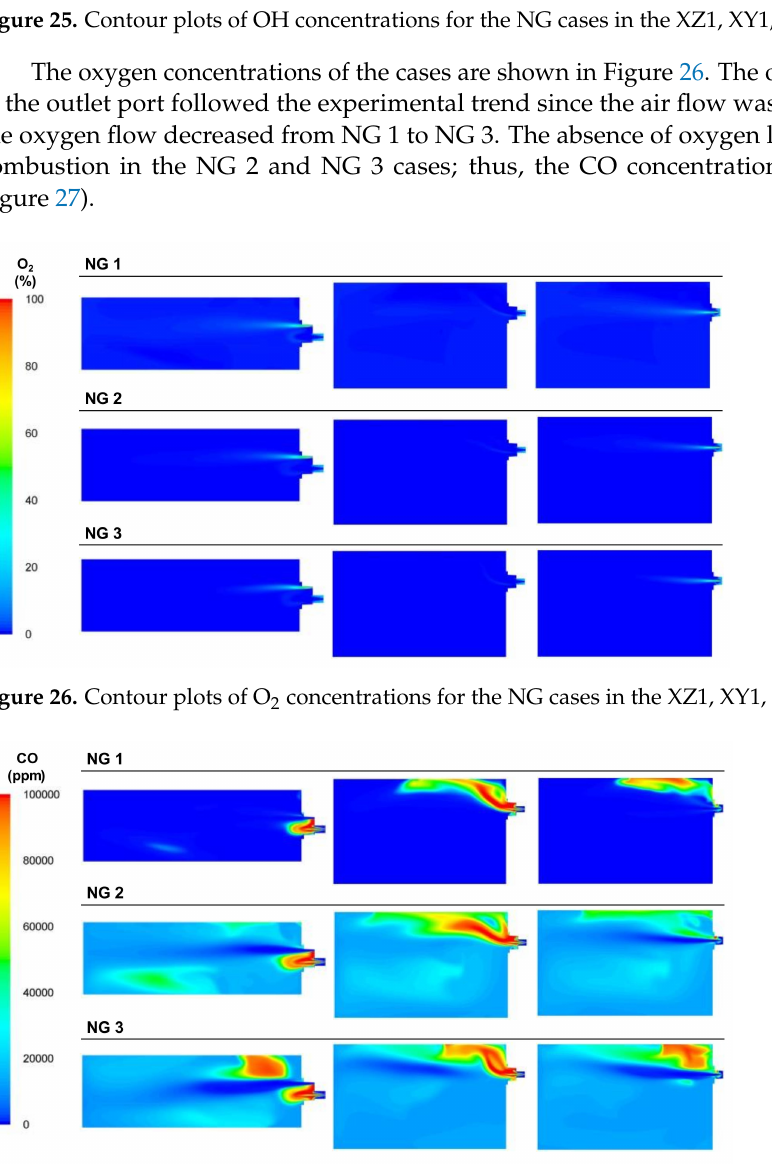
Figure 27. Contour plots of CO concentrations for the NG cases in the XZ1, XY1, and XY2 planes. The NOx rates of the NG cases are shown in Figure 28. The high combustion temper- atures and the presence of oxygen in the area immediately after the burner favored